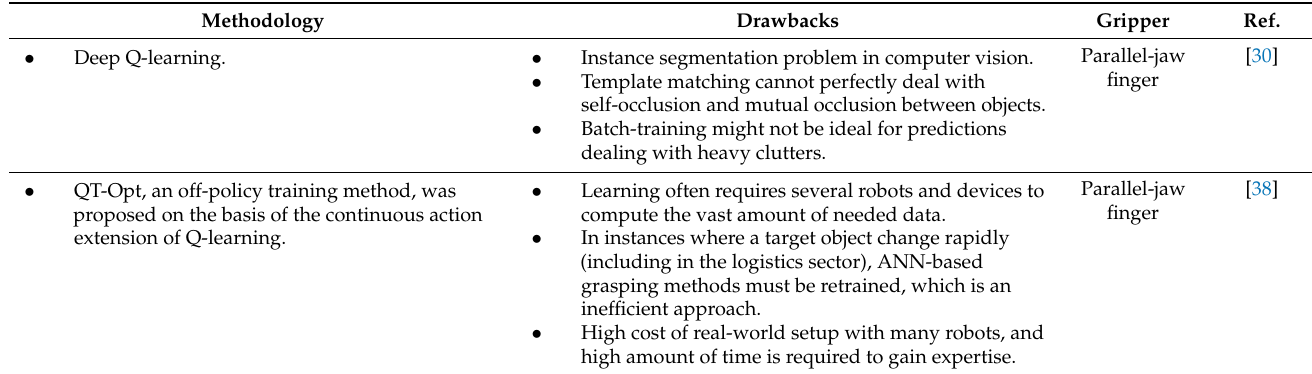
Table 2. Summary of the relevant papers on the sole-grasping